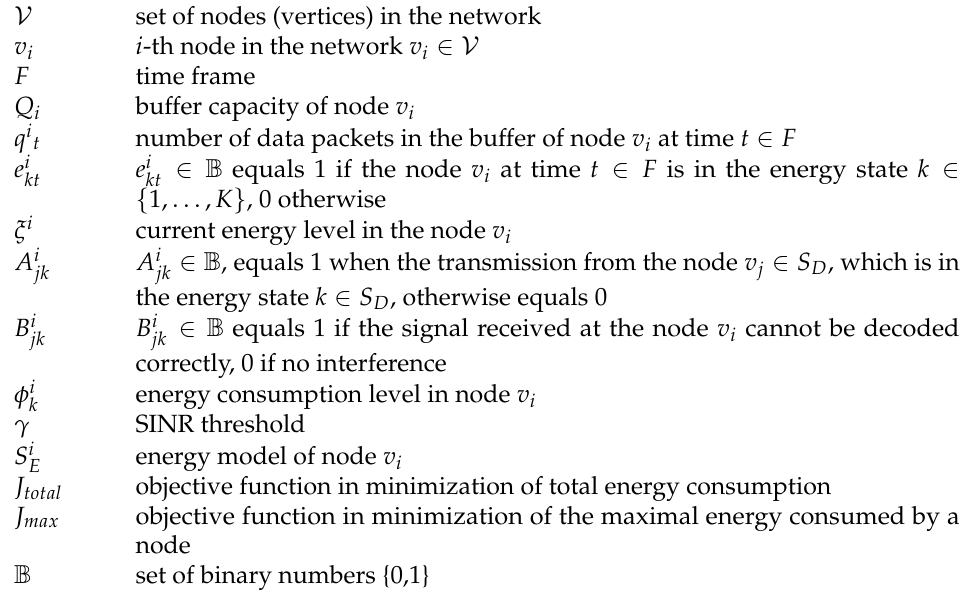
Table 1. Summary of